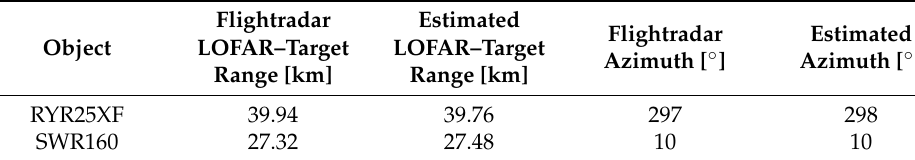
Table 3. Target range and azimuth—April 2019.